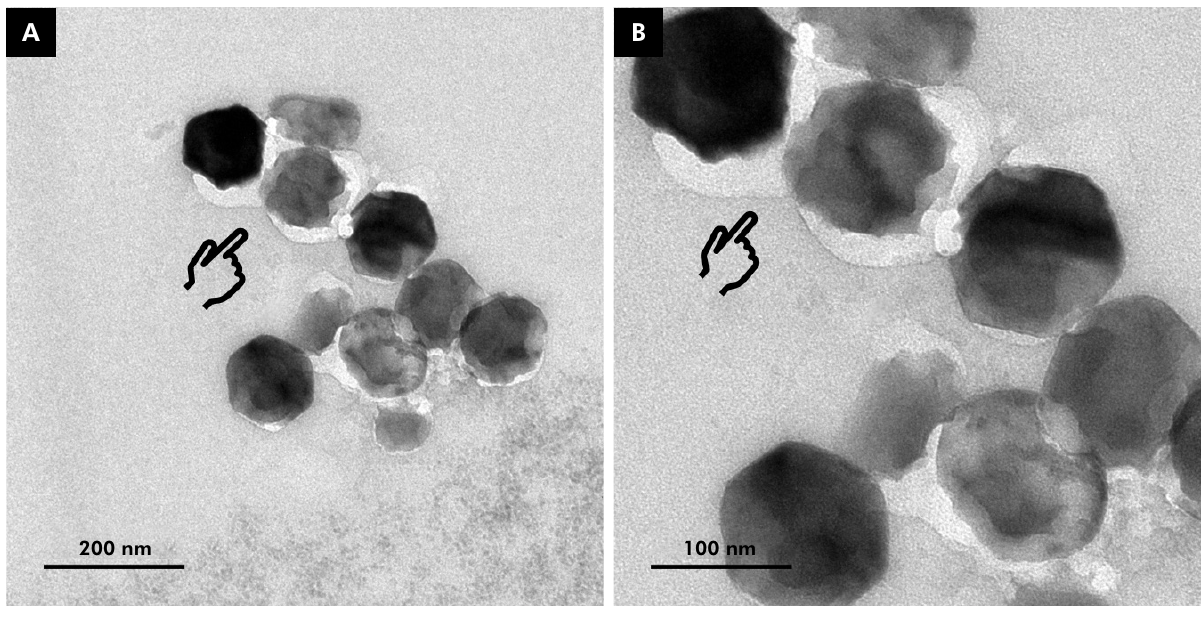
Figure 7. TEM image at of the non-functionalized UCNPs incorporated into the dental adhesive at (A) 100,000X, and (B) 300,000X magnification. Notice the generalized presence of voids indicated by the pointer, and the inability of the cured resin matrix to coat the particles.